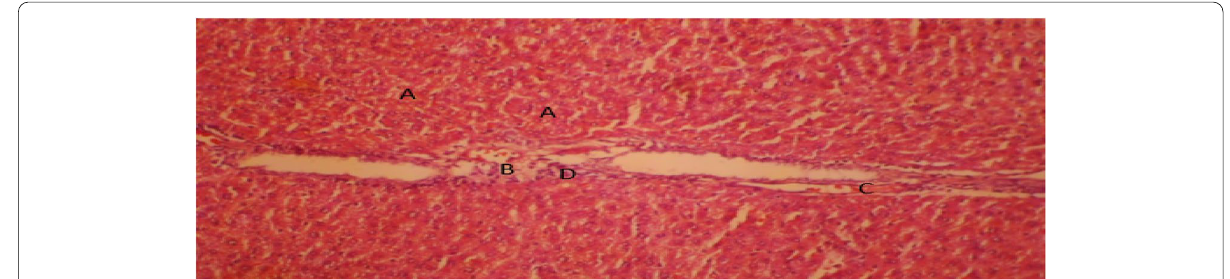
Fig. 4 Liver section of rat given SA only for 14 days (Group 2) showing: A , severe microvesicular steatosis, B , severe vascular ulceration, C , mild vascular congestion and D , mild periportal infiltrates of inflammatory cells (H&E x 100)